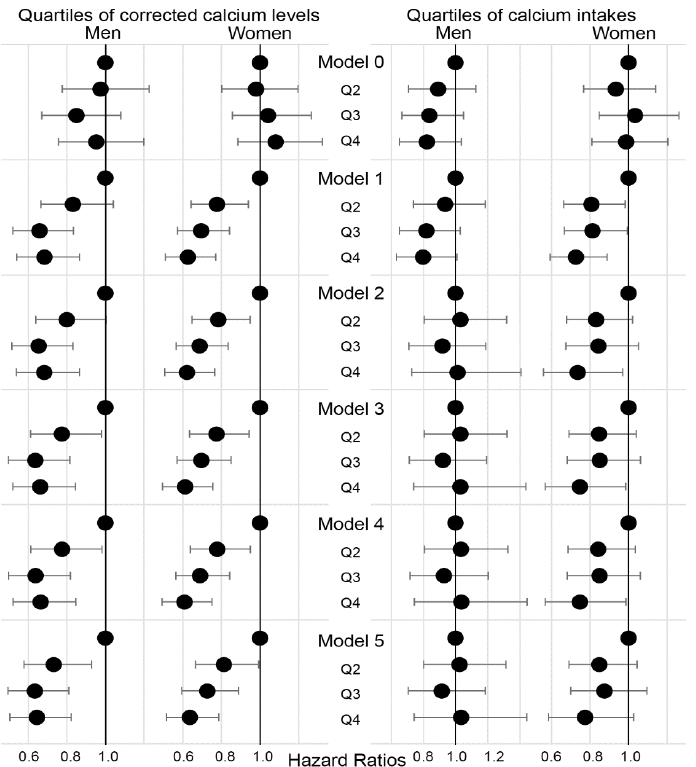
Figure 4. Hazard ratios for quartiles of corrected calcium levels and daily calcium intake. Models 0 and 1 are crude models for weight loss and muscle loss, respectively. Model 2 is a model for muscle loss adjusted for age, height, energy and protein intake, and lifestyle habits. Model 3 additionally adjusts for variables related to renin-angiotensin system and metabolic parameters. Model 4 additionally adjusts for history of hypertension and diabetes. Model 5 additionally adjusts for baseline muscle